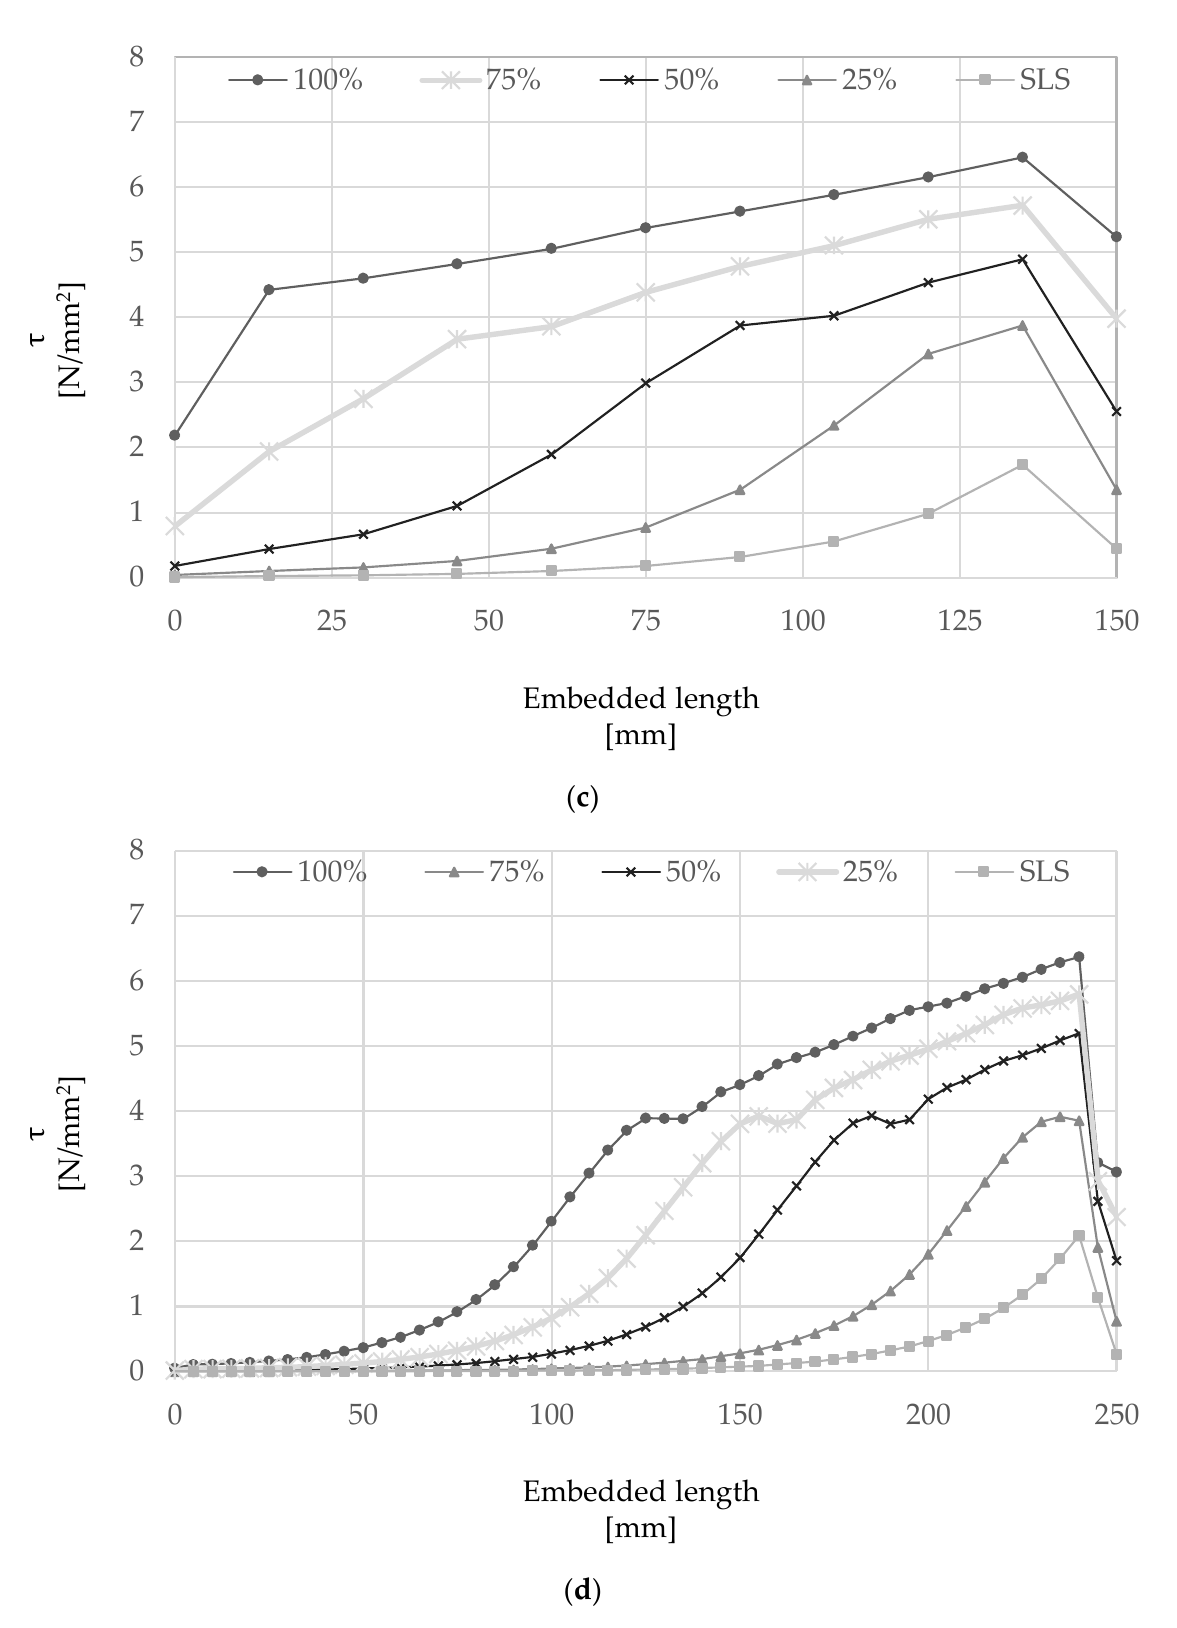
Figure 11. Shear stress distribution at various load levels along cords of different embedment lengths: ( a ) 50 mm, ( b ) 100 mm, ( c ) 150 mm and ( d ) 250 mm.